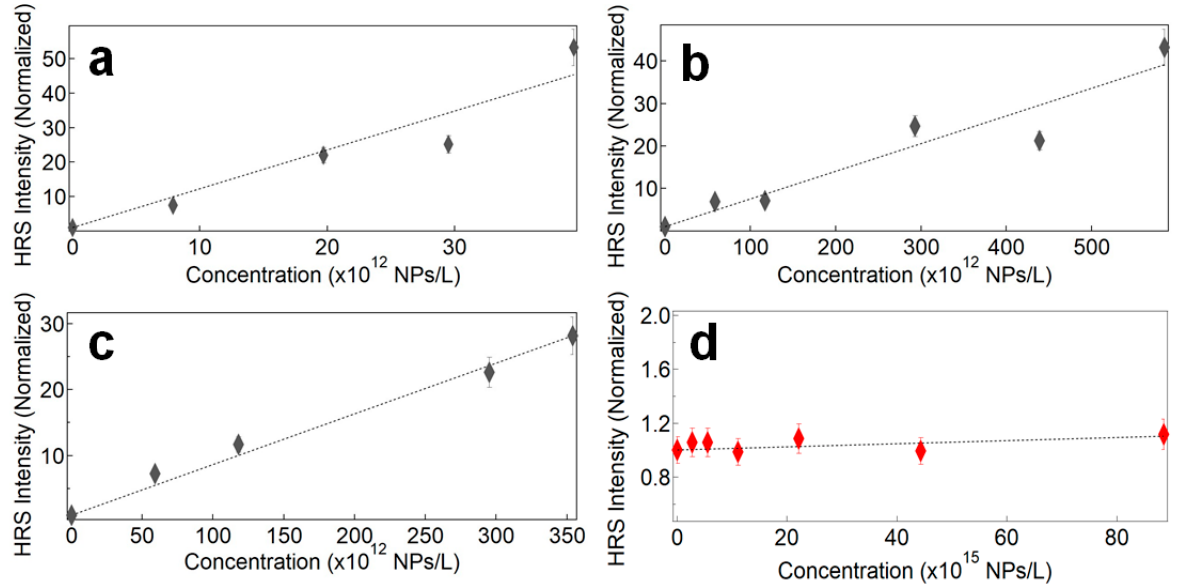
Figure 6. Normalized HRS intensities as a function of the NP concentration. ( a ) LN@BPEI@AuSeeds300, ( b ) LN@BPEI@Au- Seeds1000, ( c ) LN@BPEI@AuSeeds3000, ( d ) AuSeeds.